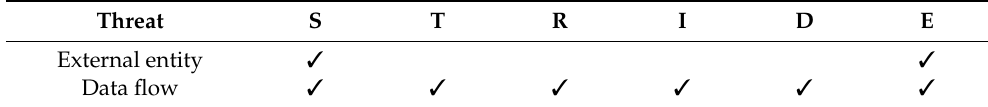
Table 14. Threats available in DFD components.